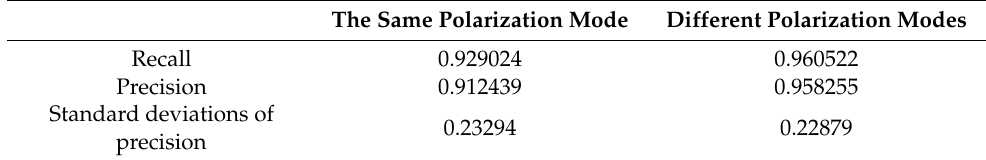
Table 6. Average recall and precision of the same polarization mode and different polarization